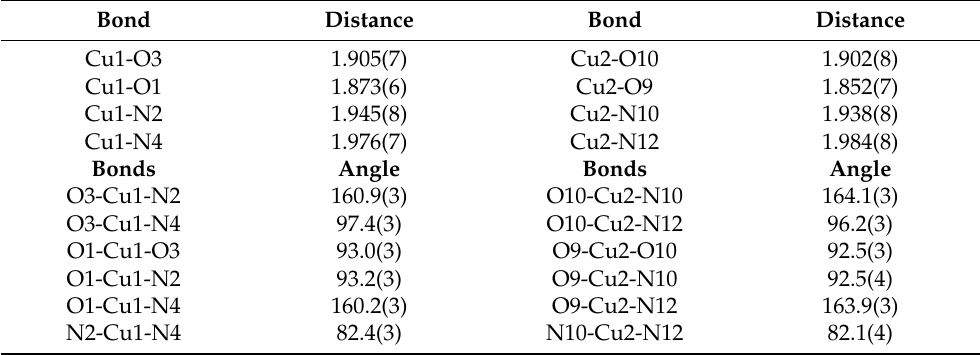
Table 3. The most important bond distances (Å) and angles (˚) for complex 2 .